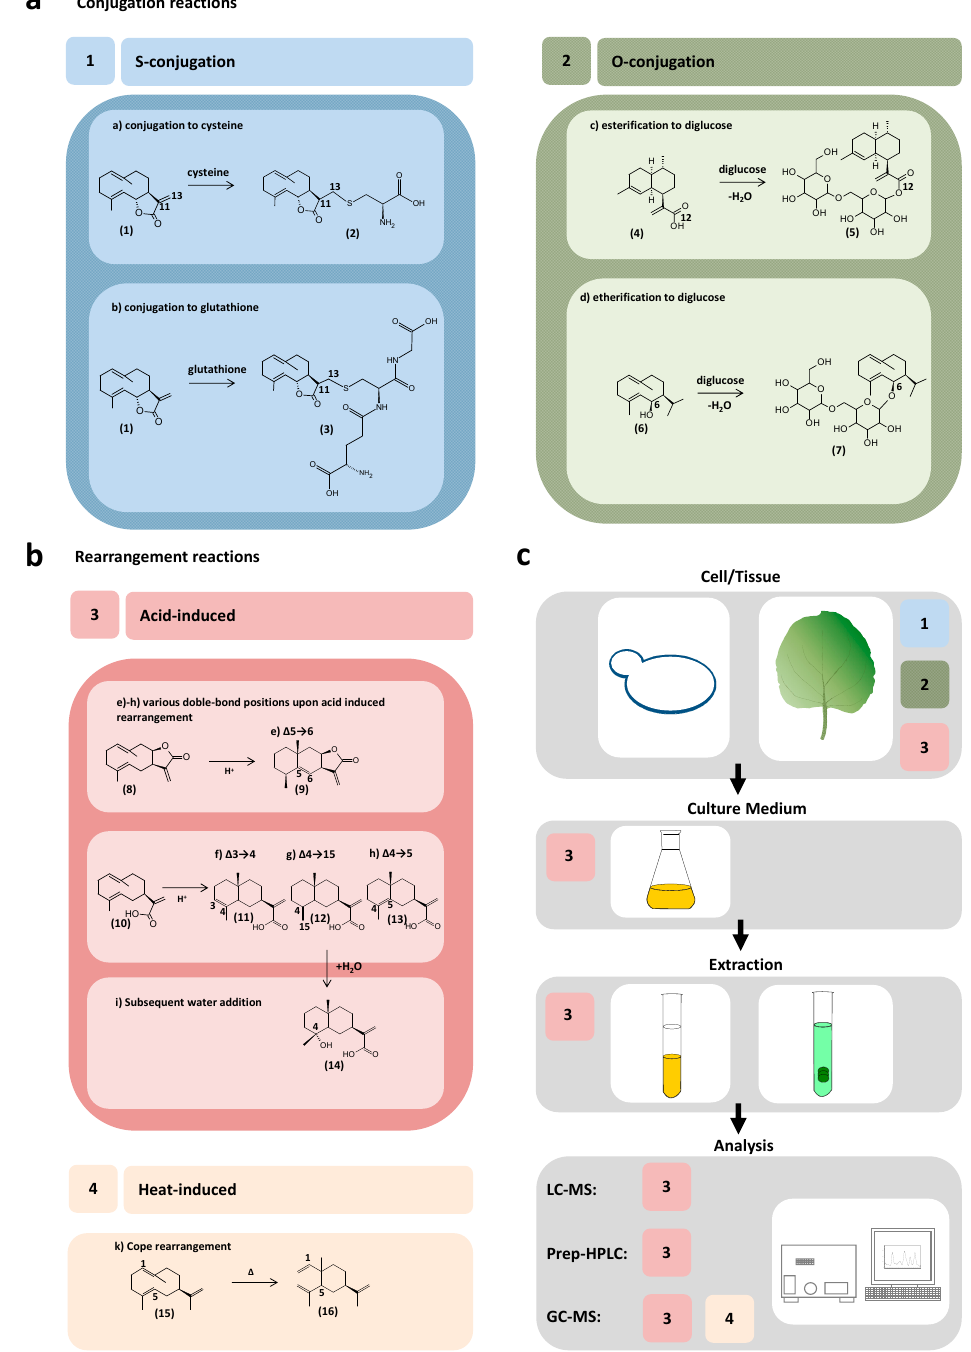
Figure 1. Unspecific rearrangement and conjugation reactions of sesquiterpenoids in heterologous expression systems. ( a ) Conjugation reactions; ( b ) Rearrangement reactions; ( c ) Unspecific reactions in the workflow of enzyme characterization.